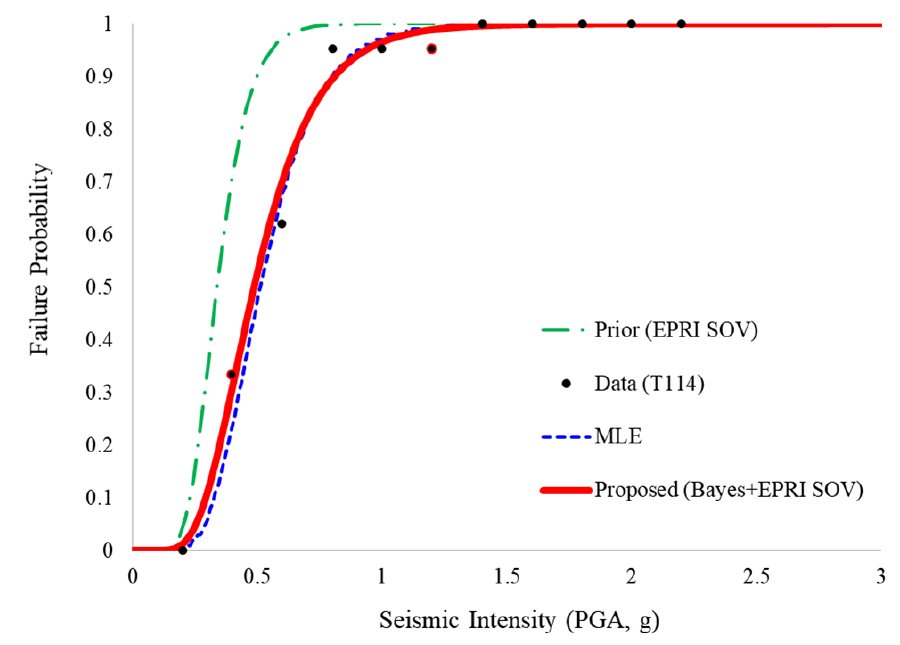
Figure 10. Piping seismic fragility curve regarding a limit state of seismically vulnerable T-joint T114.